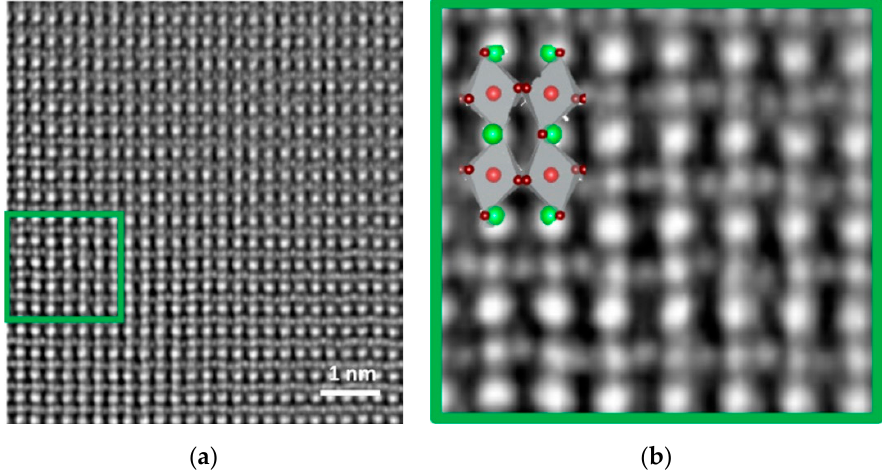
Figure 21. ( a ) iDPC-STEM image of the LSMO layer in the virgin state; ( b ) is the enlarged image of the green box in a ). Reprinted/adapted with permission from Ref. [118]. Copyright 2021, AIP Pub-lishing.